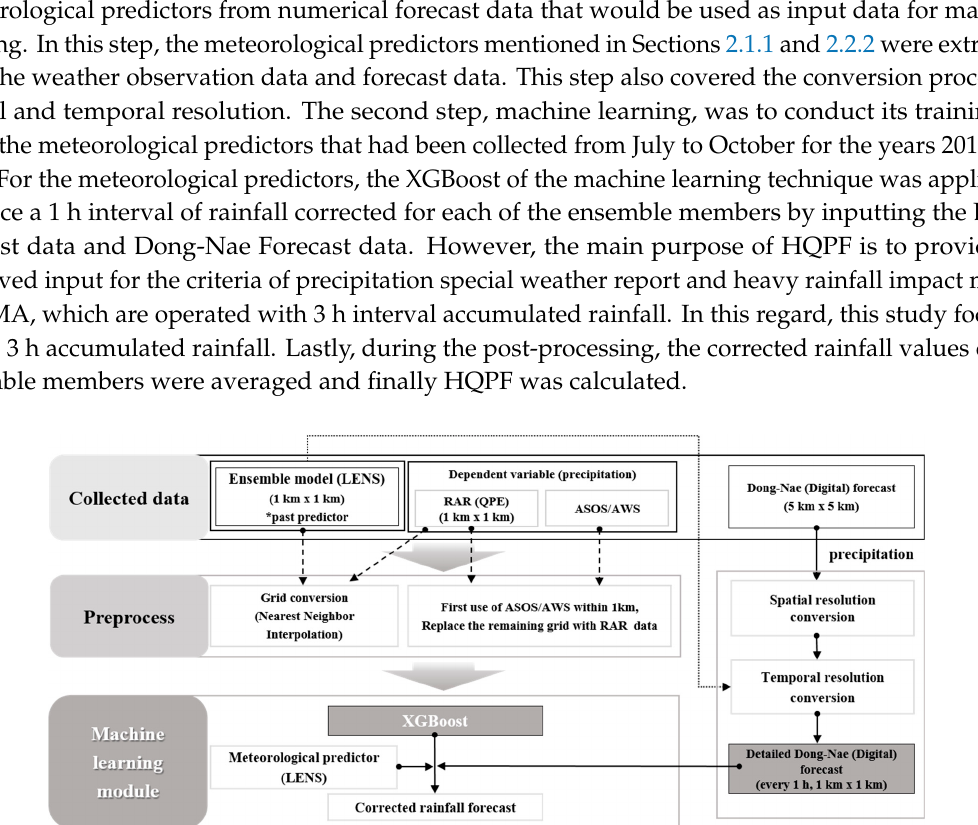
Figure 3. HQPF calculation process.